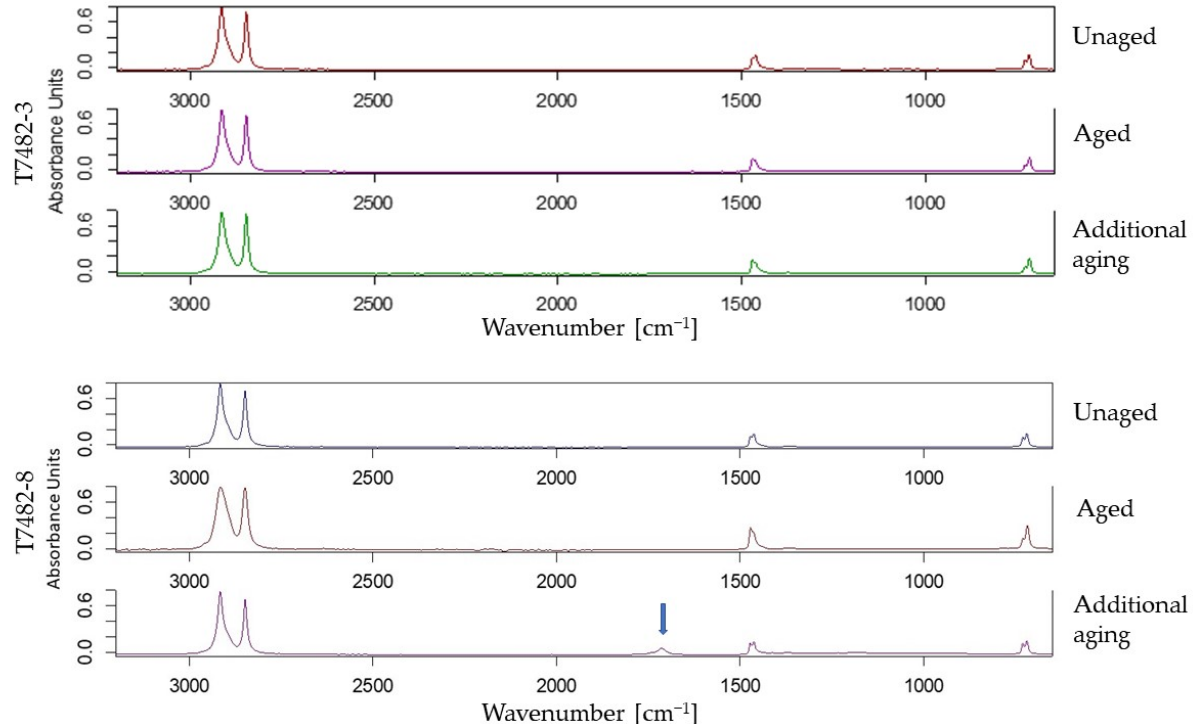
Figure 12. In the upper figure, ATR-FTIR spectra of T7482-3 shows no significant chemical changes for unaged samples ( top ), after aging ( middle ) or additional aging ( bottom ). By comparison, in the lower figure, ATR-FTIR spectra of T7482-8 shows no significant chemical changes for unaged samples ( top ), nor after aging ( middle ), but the distribution and formation of new peaks centred around 1720 cm − 1 due to oxidation, is evident after additional aging for 50 days ( bottom ).